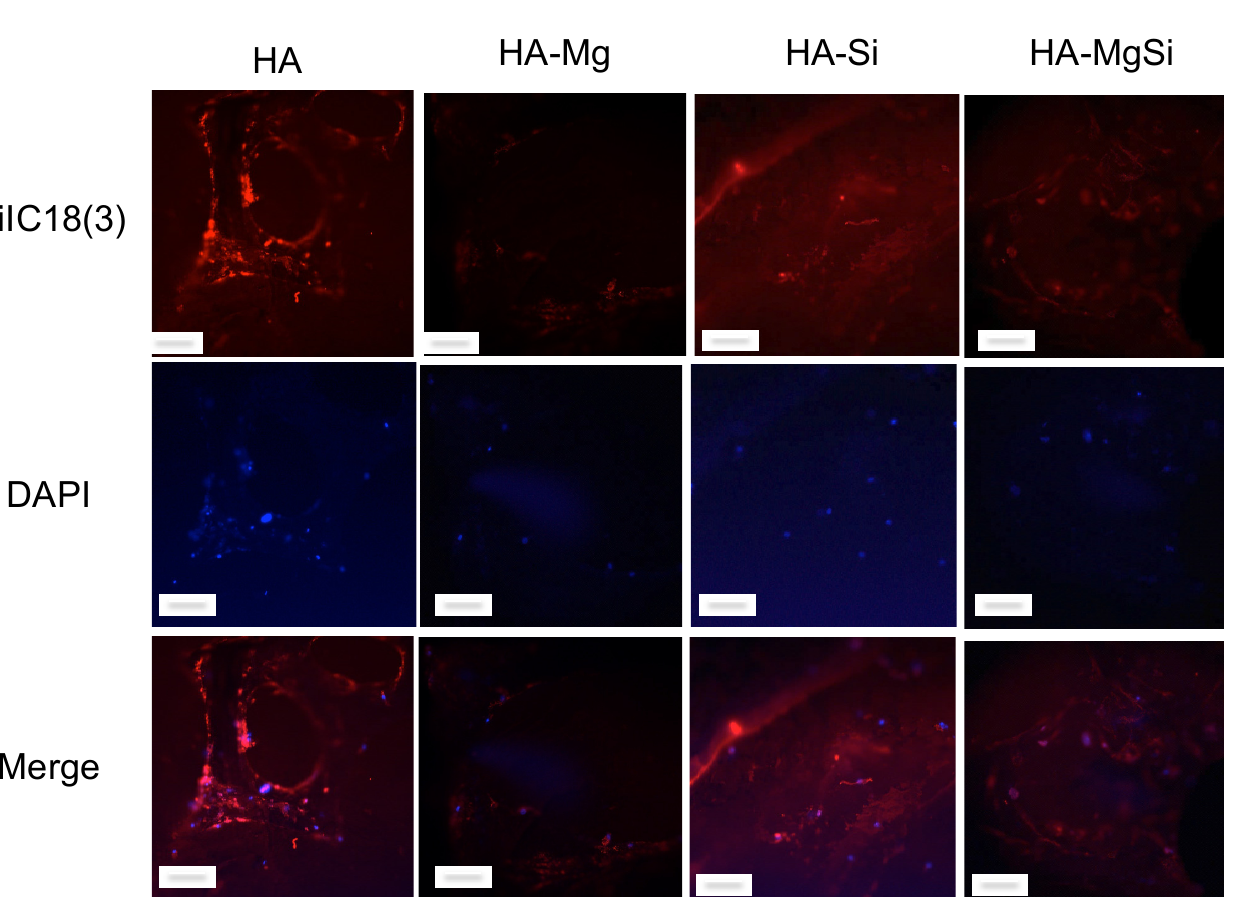
Figure 9. Confocal microscopy images of BMSC seeded on ceramic scaffolds after seven days of culture. Viable cells incorporated DiIC18(3) label (red) into their membrane, and nuclei were stained with DAPI (blue). Individual blue and red channels are shown, followed by merged images (scale bar = 50 μ m). Images are representative of three independent experiments.